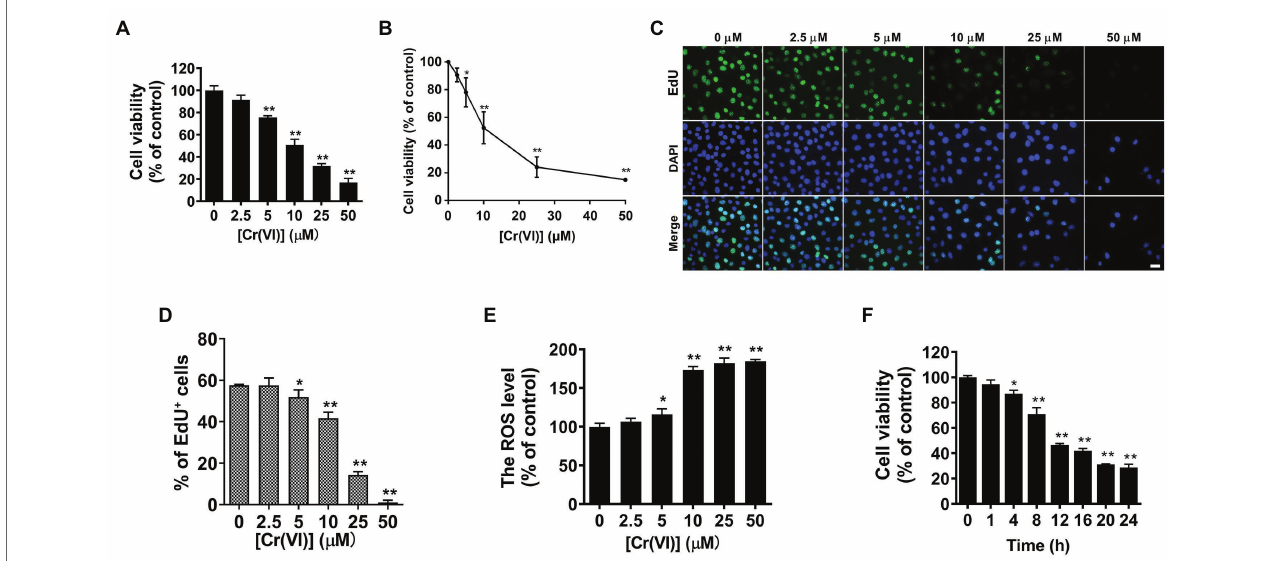
FIGURE 2 | Chromium (VI) impaired cell viability and induced reactive oxygen species (ROS) generation in SSCs/progenitors. (A,B) A Cell Counting Kit-8 (CCK-8; A ) and MTT assay (B) for the viability of SSCs/progenitors treated with different concentrations of Cr (VI) for 12 h. (C) Representative images of cells in different treatment groups that incorporate EdU. Bar = 20 μ m. (D) Quantification of cells in different treatment groups that incorporate EdU. At least 300 cells were analyzed in each group. (E) DCFH-DA detection of the intracellular ROS accumulation in SSCs/progenitors treated with different concentrations of Cr (VI) for 1 h. (F) A CCK-8 assay for the viability of SSCs/progenitors treated with 10 μ M Cr (VI) for different time. Data are presented as the mean ± SEM of three independent experiments. * p < 0.05; ** p <